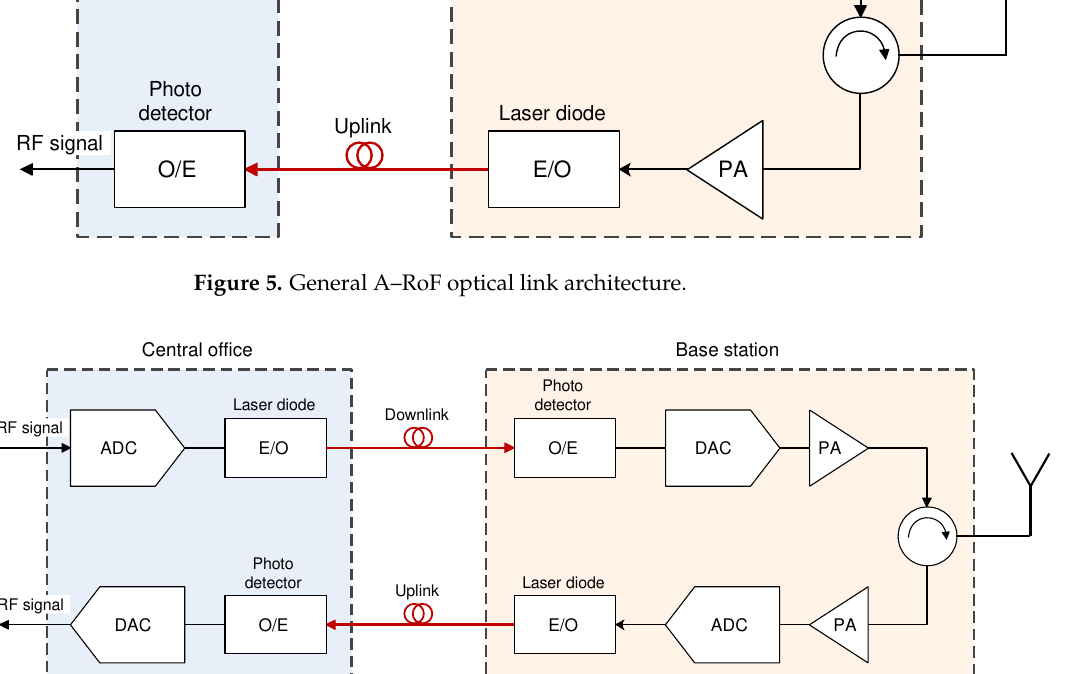
Figure 6. General D – RoF optical link architecture.